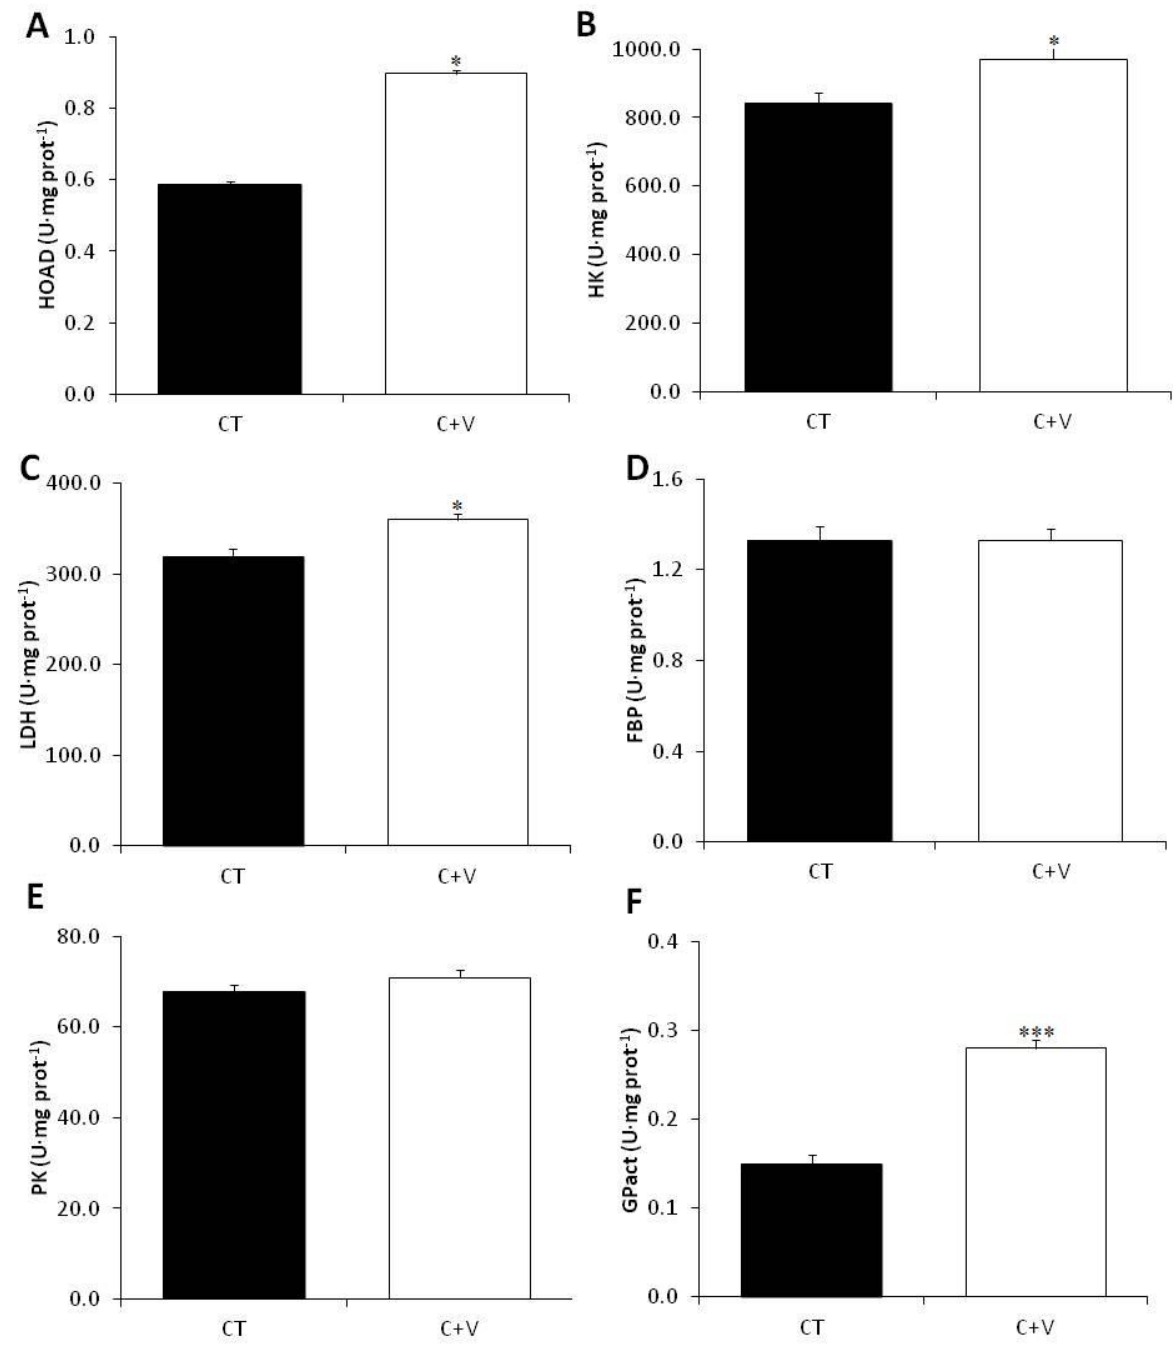
Figure 1. Specific activity (U mg protein − 1 as mean ± SEM) of metabolic enzymes in the liver of juvenile C. labrosus fed the control (CT) and C. fusca + V. proteolyticus (C + V) diets for 90 days. Asterisks denote significant differences at p < 0.05 (*), p < 0.01 (**), and p < 0.001 (***). ( A ) HOAD: 3 − hydroxy- acyl − CoA dehydrogenase; ( B ) HK: hexokinase; ( C ) LDH: lactate dehydrogenase; ( D ) FBP: fructose 1,6 − bisphosphatase; ( E ) PK: pyruvate kinase; ( F ) GPase: glycogen phosphorylase (active).